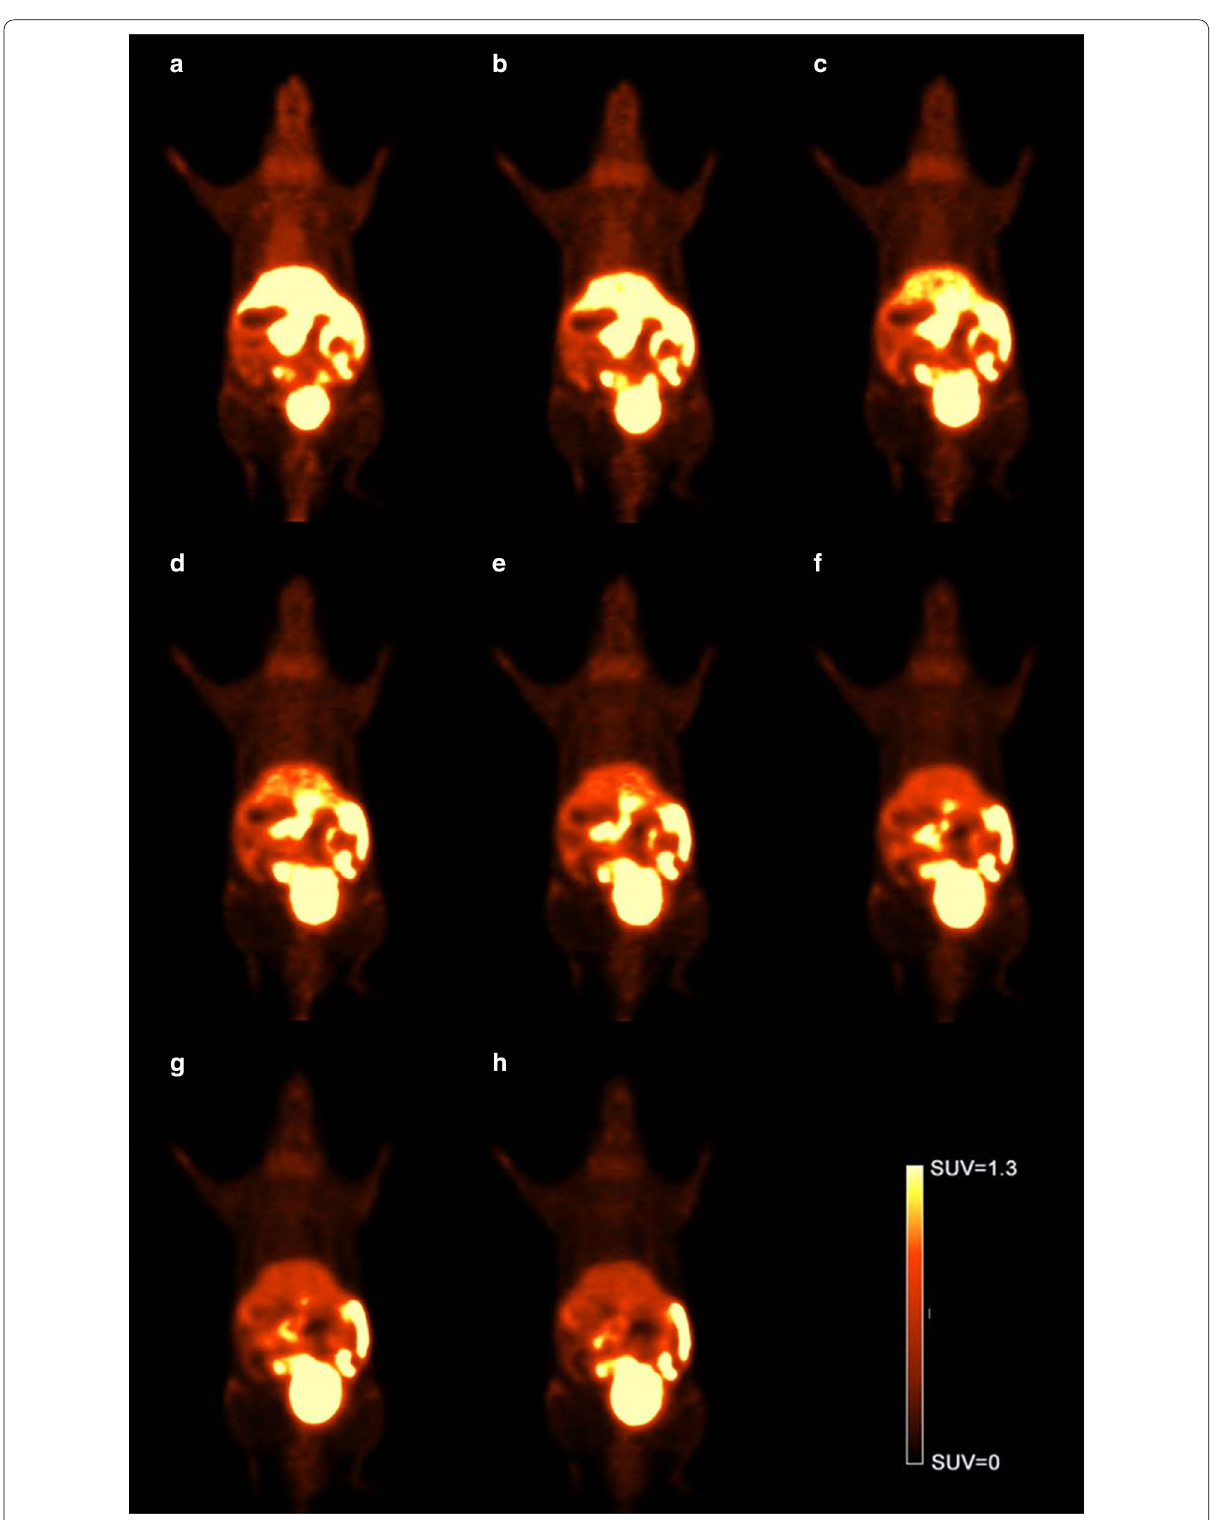
Fig. 5 Dynamic micro-PET/CT Scanning within 60 min. The representative results from one ICR mouse. a The 11th frame (5–10 min). b The 12th frame (10–15 min). c The 13th frame (15–20 min). d The 14th frame (20–25 min). e The 15th frame (25–30 min). f The 16th frame (30–40 min). g The 17th frame (40–50 min). h The 18th frame (50–60